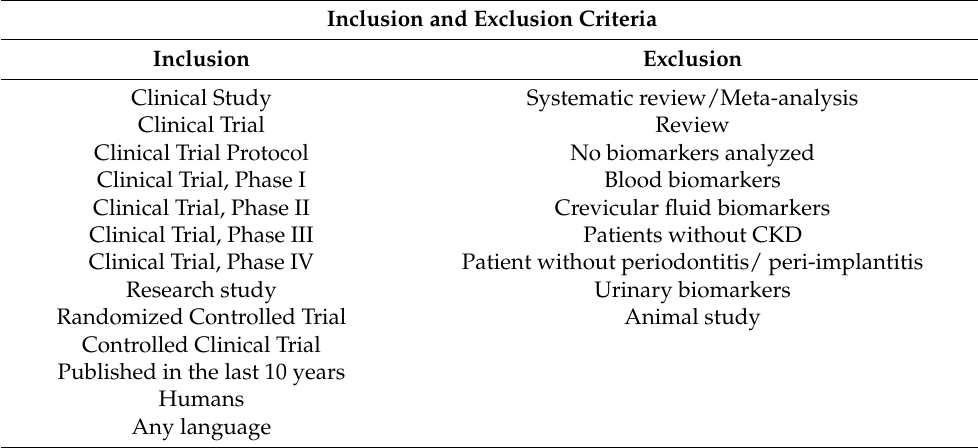
Table 2. Inclusion and exclusion criteria used for selection of the